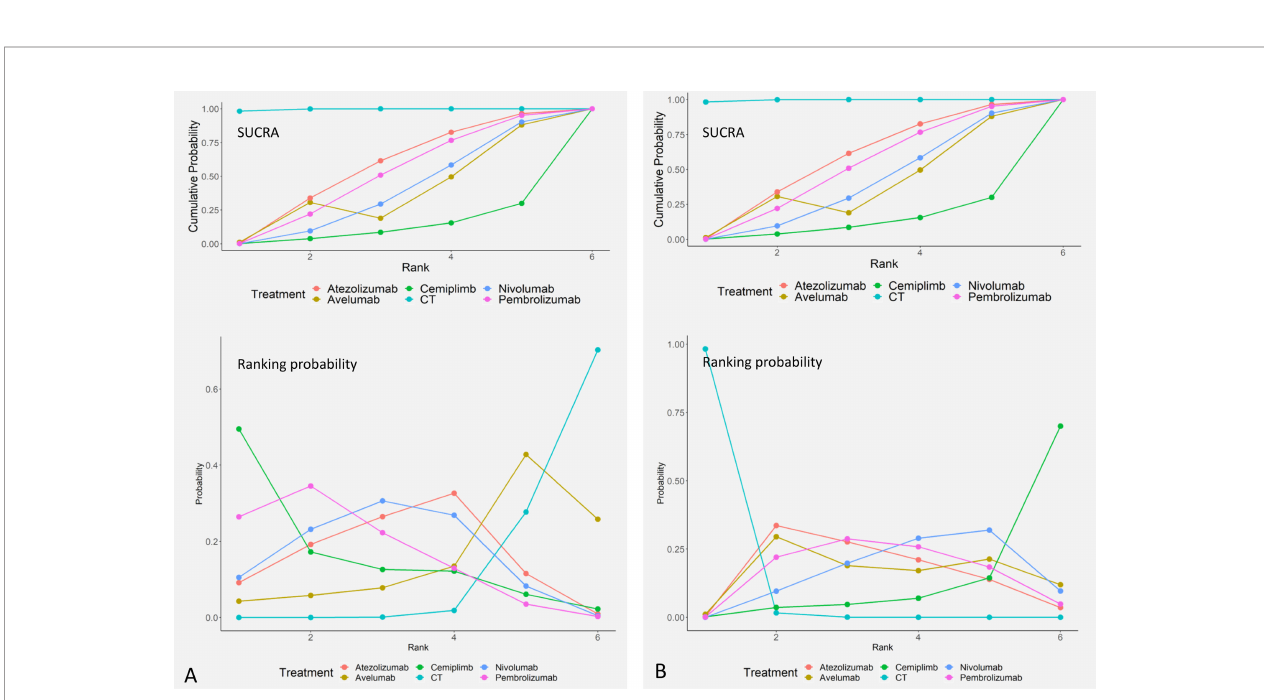
FIGURE 4 | Ranking of overall survival (OS) (A) and treatment-related adverse events (TRAEs) (B) .